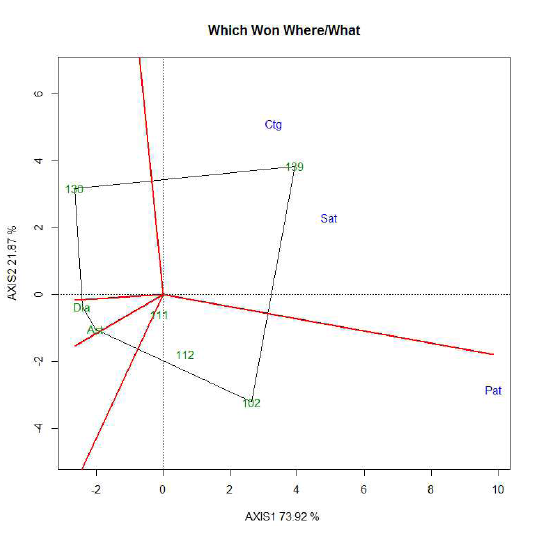
Figure 7: Ranking the test environments relative to the highest yielding genotypes at 3 locations during 2013-14 (Ctg=Chittagong, Pat=Patuakhali and Sat=